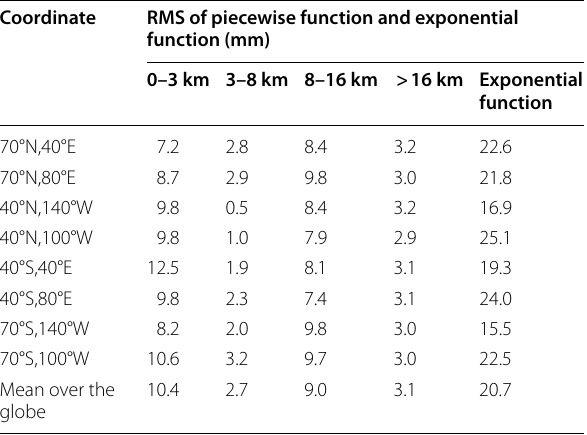
Table 1 The fitting error of piecewise function and exponential function Coordinate RMS of piecewise function and exponential function (mm)